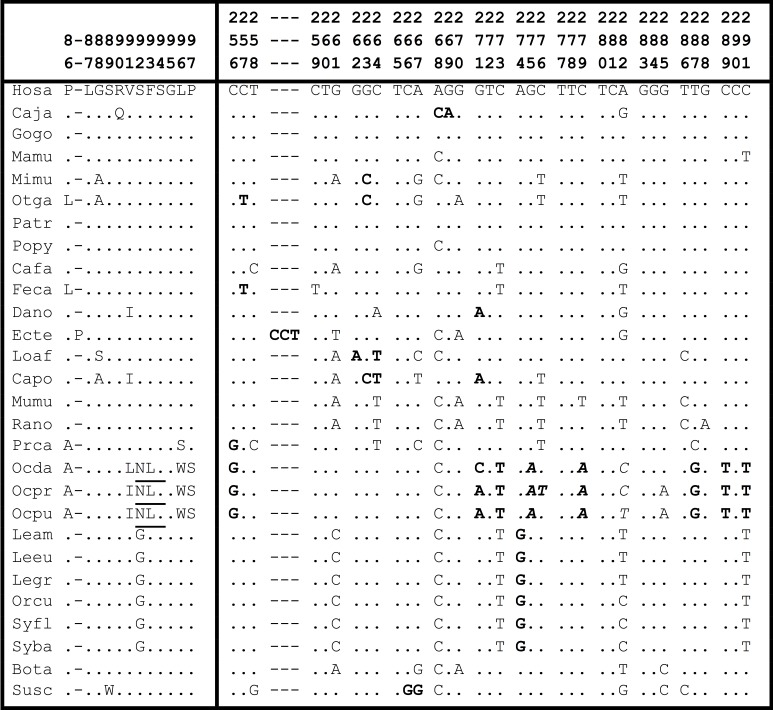
Amino acid and nucleotide sequences, corresponding to the 12 amino acids region for the 28 mammals used in this study.Bolded underlined region in the human sequence: RVSF motif; Underlined region: novel glycosylation site in Ochotona species; Bolded region: non-synonymous substitutions; Italic bolded region: nucleotide sequence corresponding to the novel glycosylation site in Ochotona species. The sequences are numbered according to human TCTEX1D4 sequence.